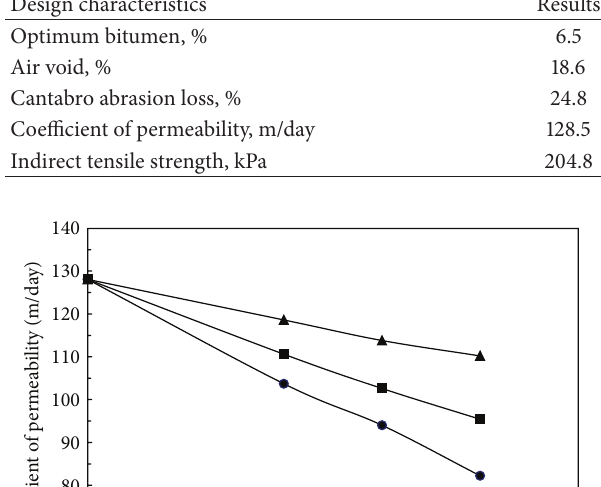
Figure 7: Effect of crumb rubber size and content on Cantabro abrasion